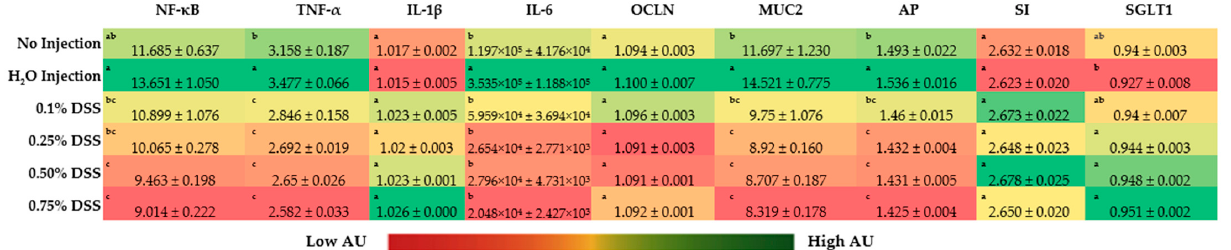
Figure 2. Effect of the intra-amniotic administration of DSS on intestinal gene expression on the day of hatch within the small intestine (duodenum). Values are means ± stand error, n = 5. a,b,c within a column, means without a common letter are significantly different, p < 0.05 (Duncan’s post-hoc test). NF- κβ , nuclear factor kappa-light-chain-enhancer of activated B cells; TNF- α , tumor necrosis factor-alpha; IL-1 β : interleukin one beta; IL-6: interleukin 6; OCLN: occludin; MUC2, mucin 2; AP: aminopeptidase; SI: sucrose isomaltase; SGLT1: sodium-glucose transporter 1; 18s rRNA: 18S ribosomal subunit.